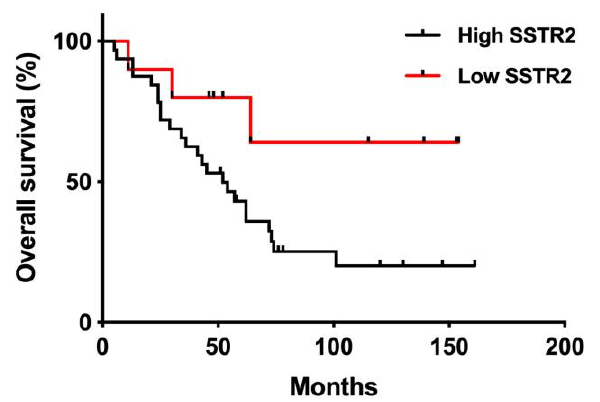
Figure 8. Overall survival of PRRT treated patients grouped according to SSTR2 expression (Low SSTR2, n = 10, High SSTR2, n = 32). Clinical characteristics of the patient groups are presented in Table 1. Patients in Low SSTR2 group had significantly prolonged OS compared with patients in High SSTR2 group. ( p = 0.049; Mantel-Cox log-rank test). Table 2. Additional treatment after PRRT. None of the patients with low SSTR2 expression received further treatment except somatostatin analogues (SSA), after PRRT. HAE = hepatic artery embolization. All Patients Additional PRRT and/or HAE